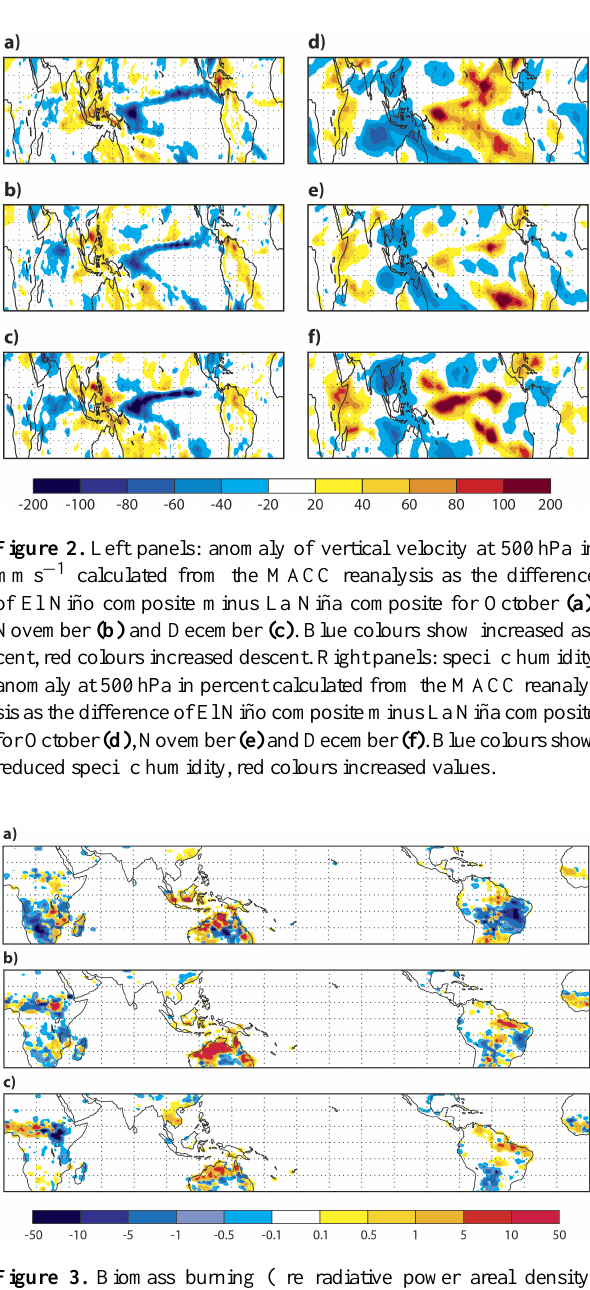
Figure 3. Biomass burning (fire radiative power areal density) anomaly in mWm − 2 calculated from the GFAS v1.0 data set as the difference of El Niño composite minus La Niña composite for October (a) , November (b) and December (c) . Red colours indicate positive values and blue colours negative